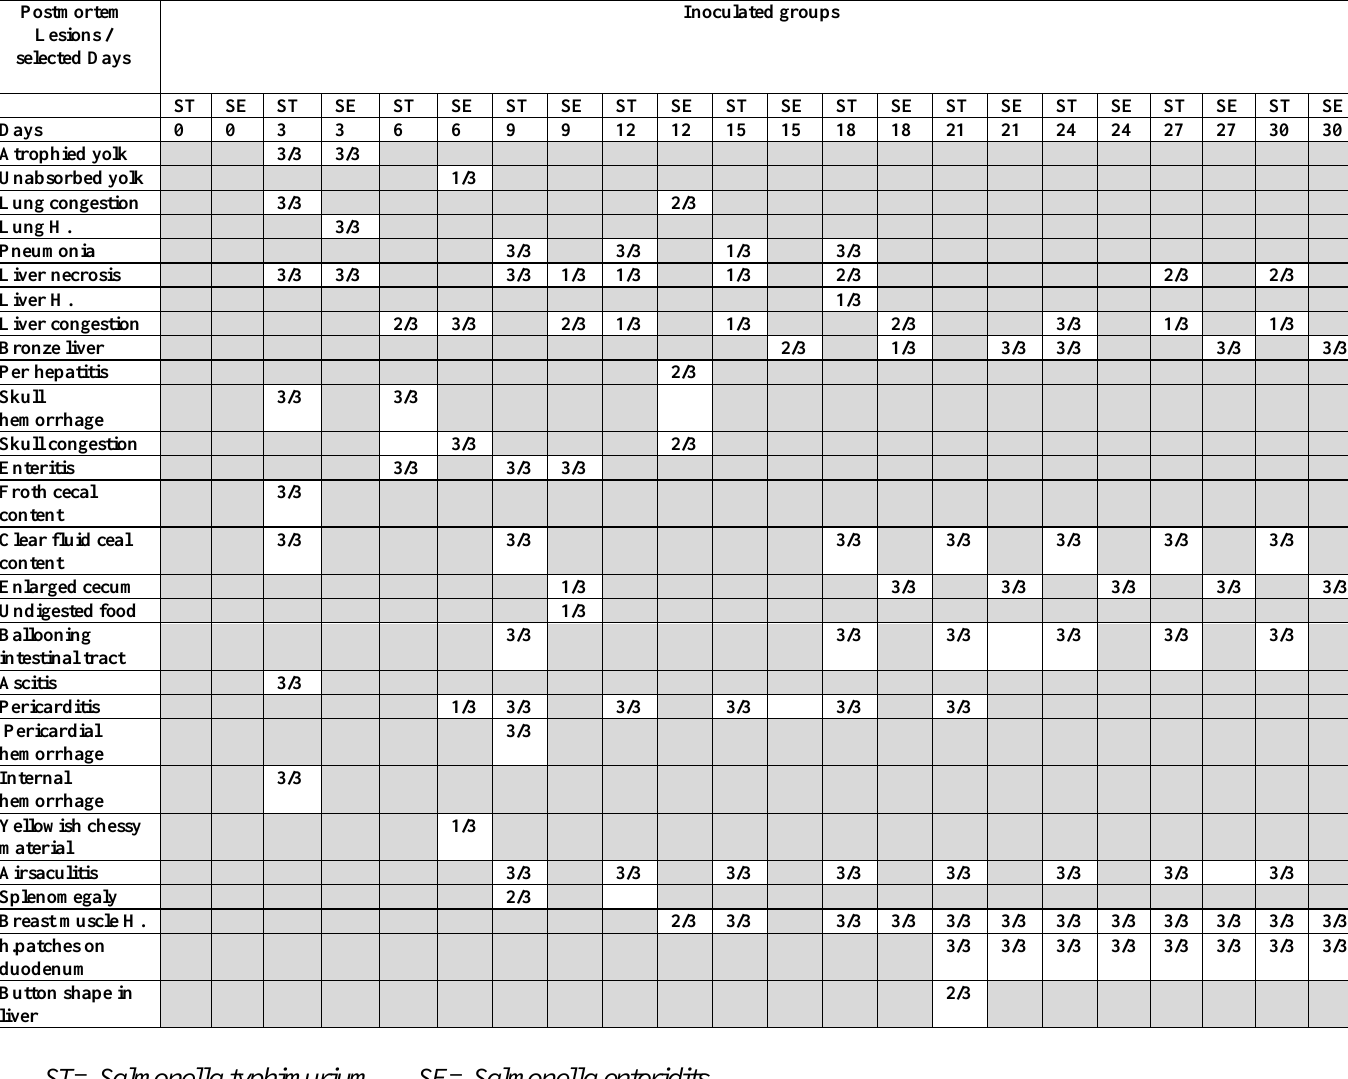
Table 3: Postmortem lesions scoring in experimental